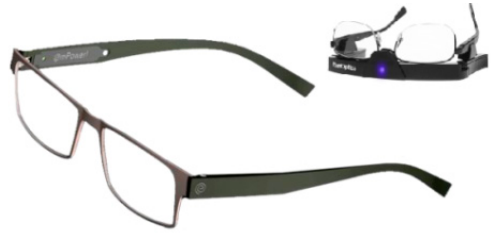
Figure 6. Commercial LC glasses with tunable focus (PixelOptics) [136].